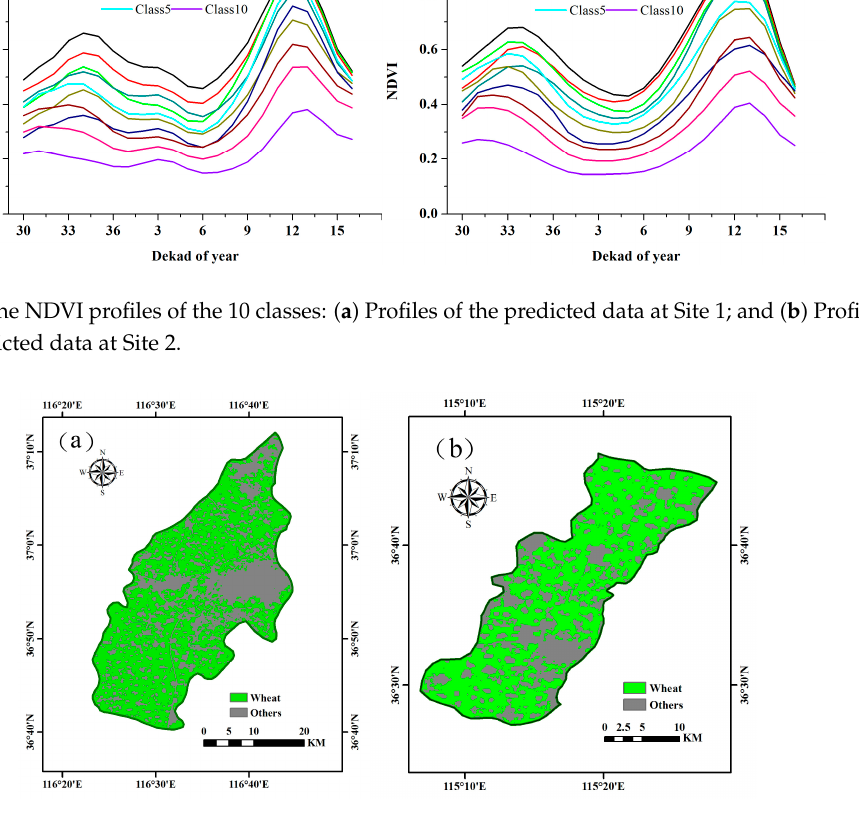
Figure 7. Classification results of the blended time-series 100-m data over the study areas: ( a ) Site 1; and ( b ) Site 2.